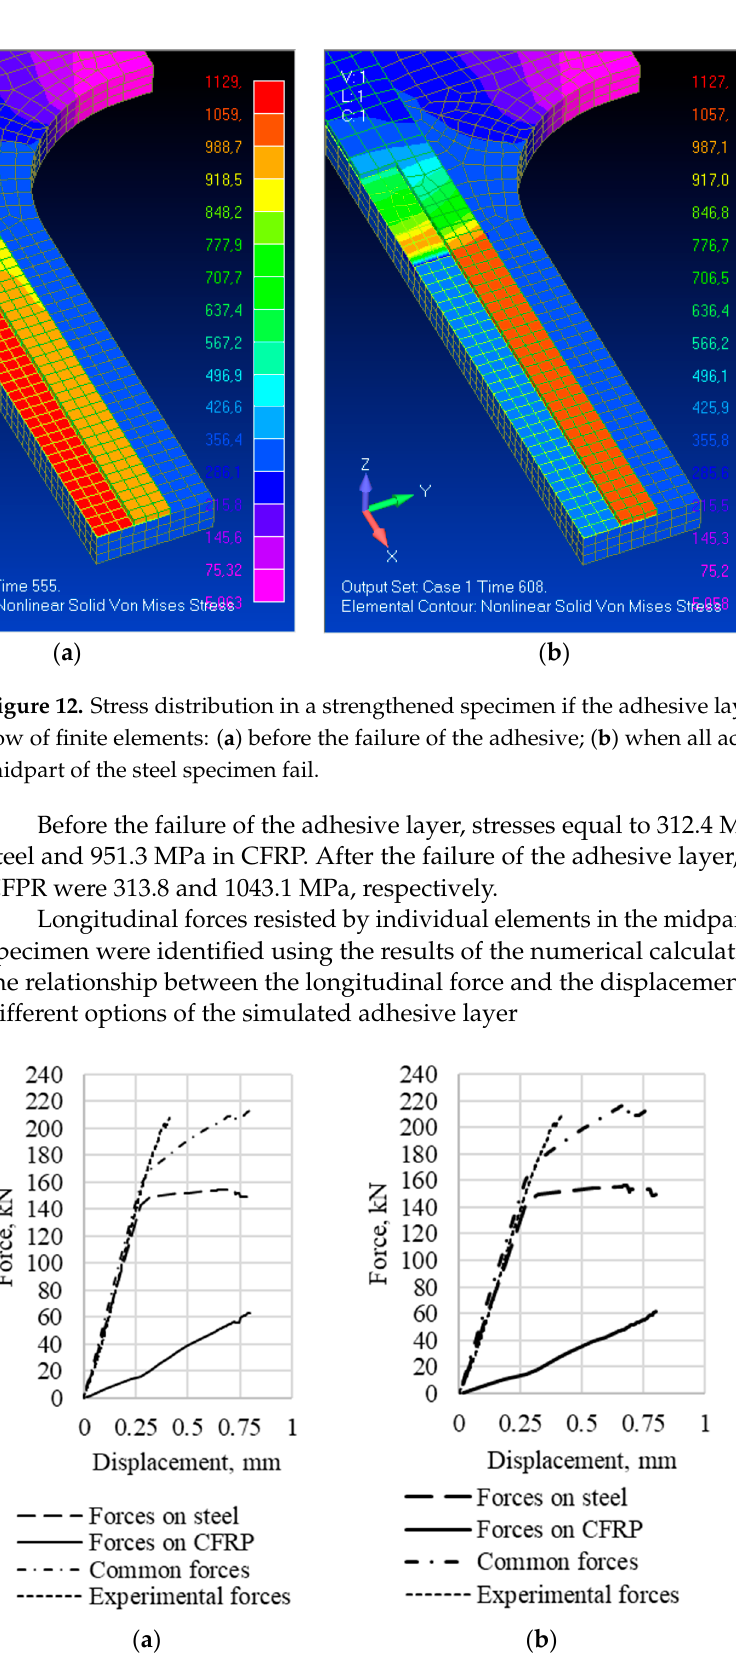
( b ) Figure 11. Stress distribution in the adhesive layer simulated by one row of finite elements before failure: ( a ) Mises stress isofield; ( b ) Mises stress values. Calculations have revealed that the greatest stresses arose in the boundary zone of the adhesive layer due to its small thickness, while all other parts of the joint remained “underloaded”. A wider zone of the adhesive joint can resist a load if the modulus of